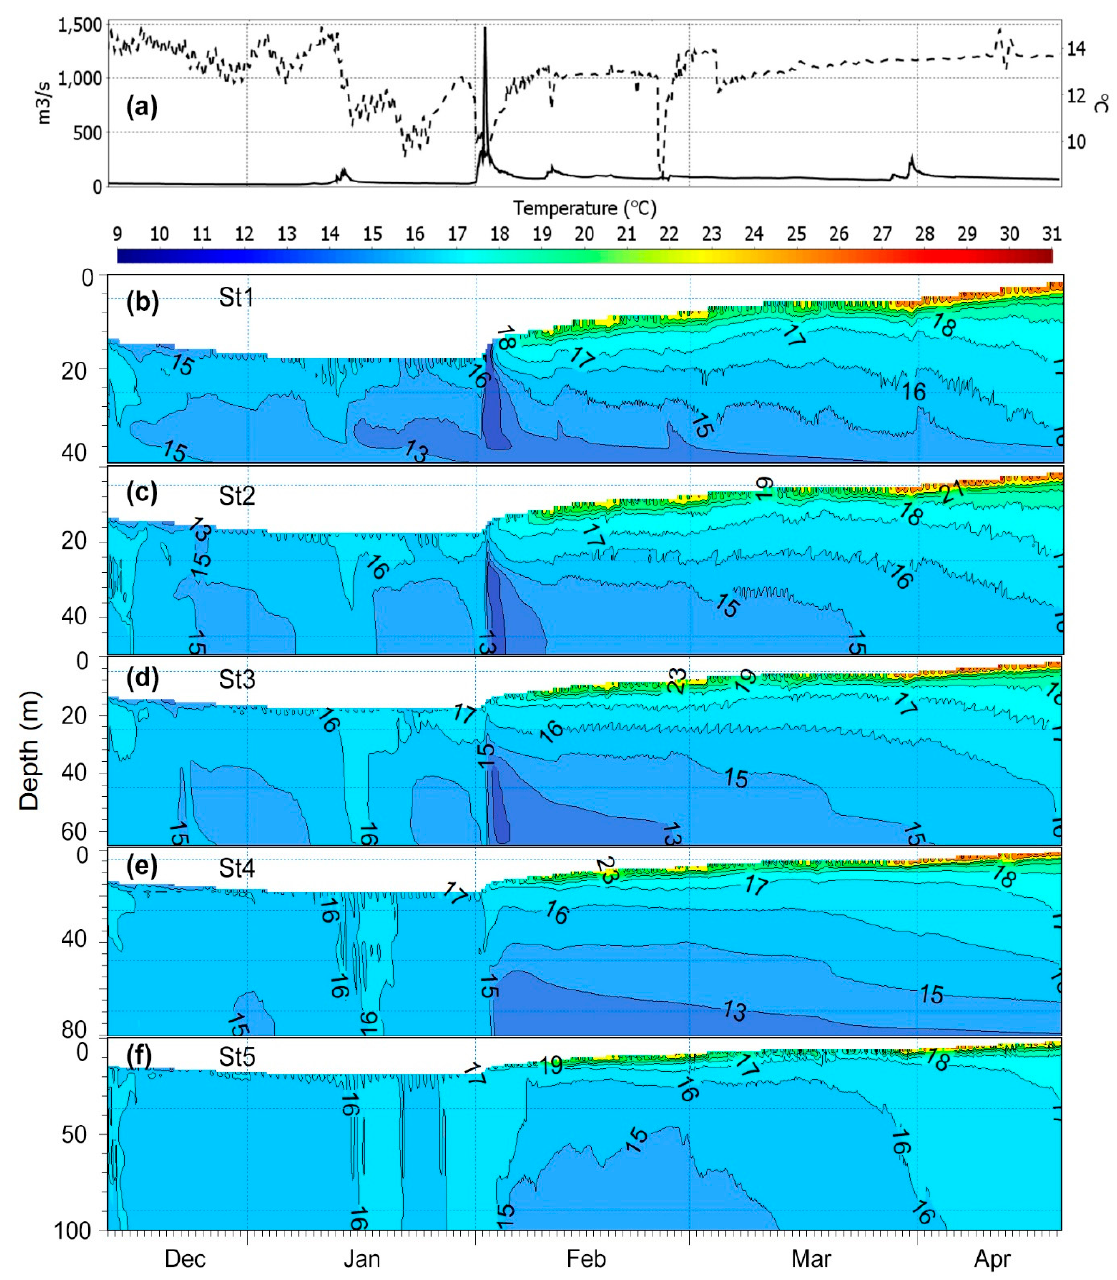
Figure 11. Similar to Figure 10, but with water column temperatures simulated by MIKE3 ( k- ε ) using z/sigma discretization .